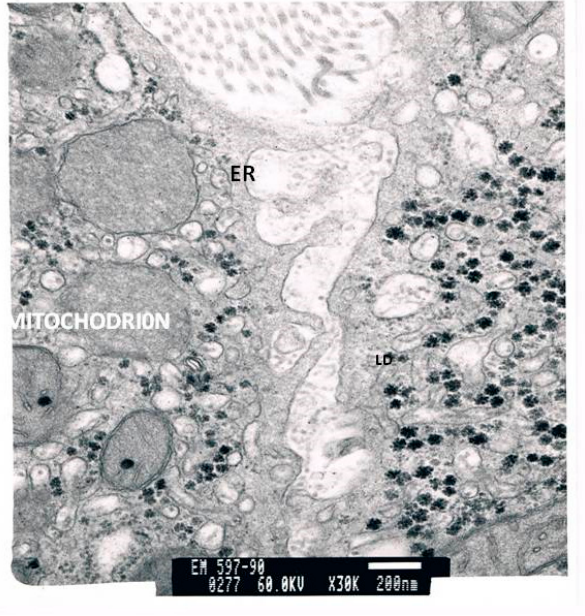
Figure 4. An electron micrograph of a liver biopsy of a patient, which shows hepatocytes containing large lipid droplets, enlarged endoplasmic reticulum, mitochondria with few cristae and HCV antibodies.